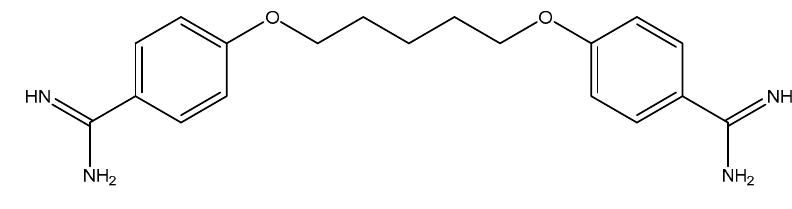
Figure 2. The chemical structure of pentamidine.